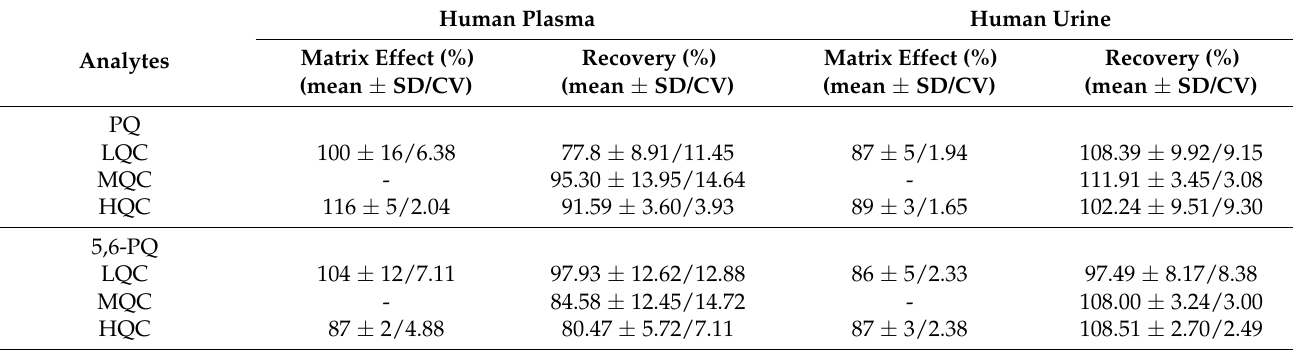
Table 1. Matrix effect ( n = 6) and recovery ( n = 9) analysis of PQ and 5,6-PQ in human plasma and urine. Human Plasma Human Urine Matrix Effect Analytes